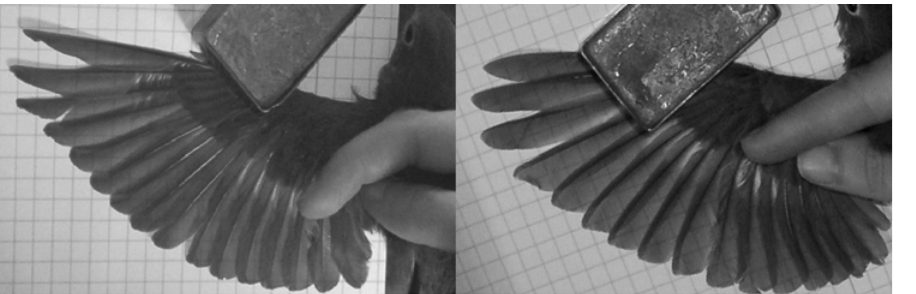
Figure 1. Wingtip shape in Swainson’s Thrushes. To the left is a relatively pointed wing (C 2 =0.139) and to the right is a relatively round wing (C 2 =0.493). Grid squares in both pictures are 6.35 mm on each side.